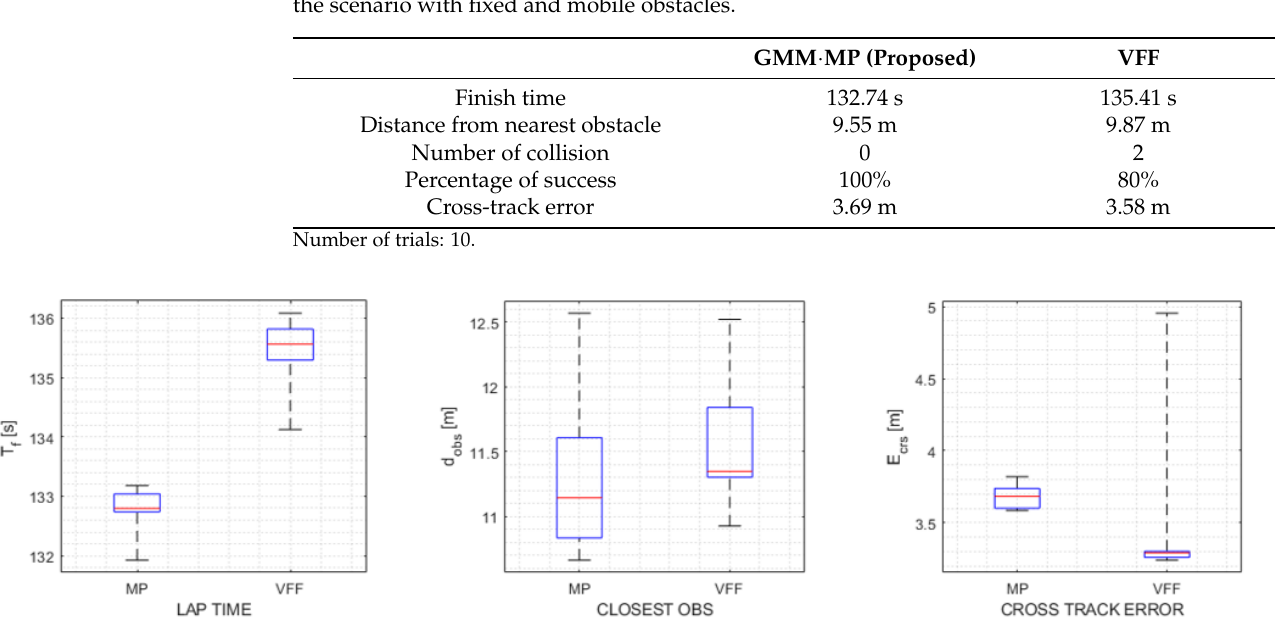
Figure 18. Comparison of GMM · MP and VFF trajectories for mobile obstacles. Table 3. Evaluation of obstacle avoidance performance of different collision avoidance methods in the scenario with fixed and mobile obstacles.